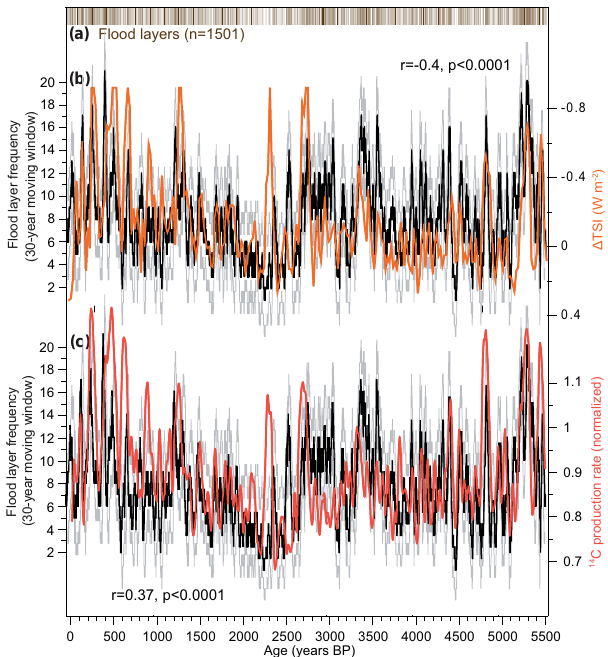
Figure 3. Flood layer frequency and solar activity. (a) Flood lay- ers in Ammersee sediment core AS10 prox . (b) Flood layer fre- quency (30-year moving window) and reconstructed total solar irradiance (difference to the value of the Davos Physical Mete- orological Observatory (PMOD) composite during the solar cy- cle minimum in AD1986) (Steinhilber et al., 2012). (c) Flood layer frequency (30-year moving window) and 14 C production rate (Muscheler et al., 2007). Gray lines indicate the standard deviation of the smoothed flood layer record. Correlations were calculated using a random-phase test (Ebisuzaki, 1997).